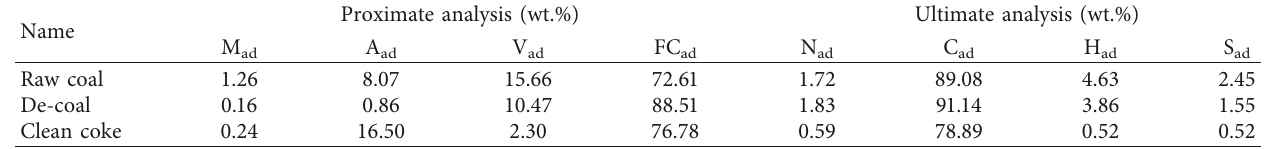
Table 1: Proximate and ultimate analysis of the samples used.